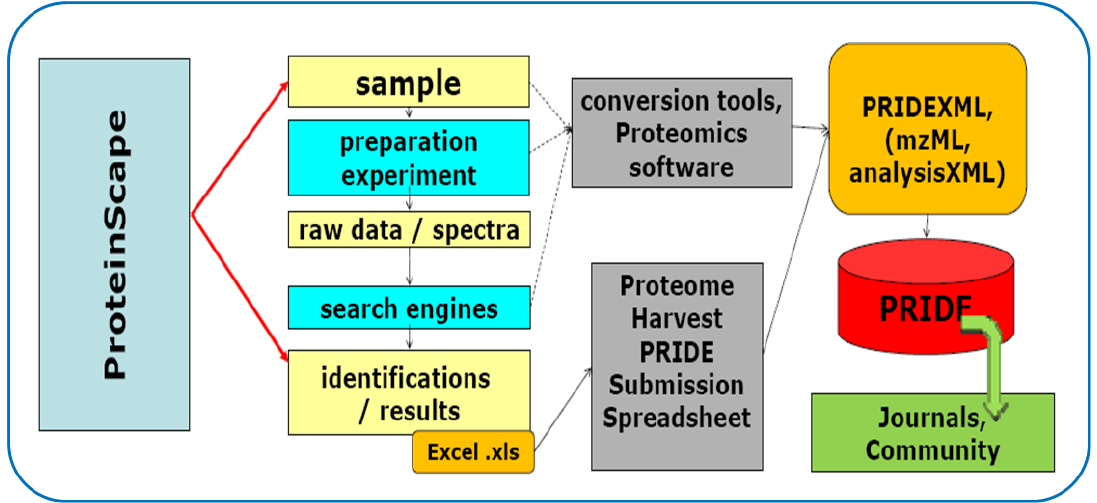
Fig. 5: Integration of Information - PRIDE as an interface between the local laboratory database and the scientific